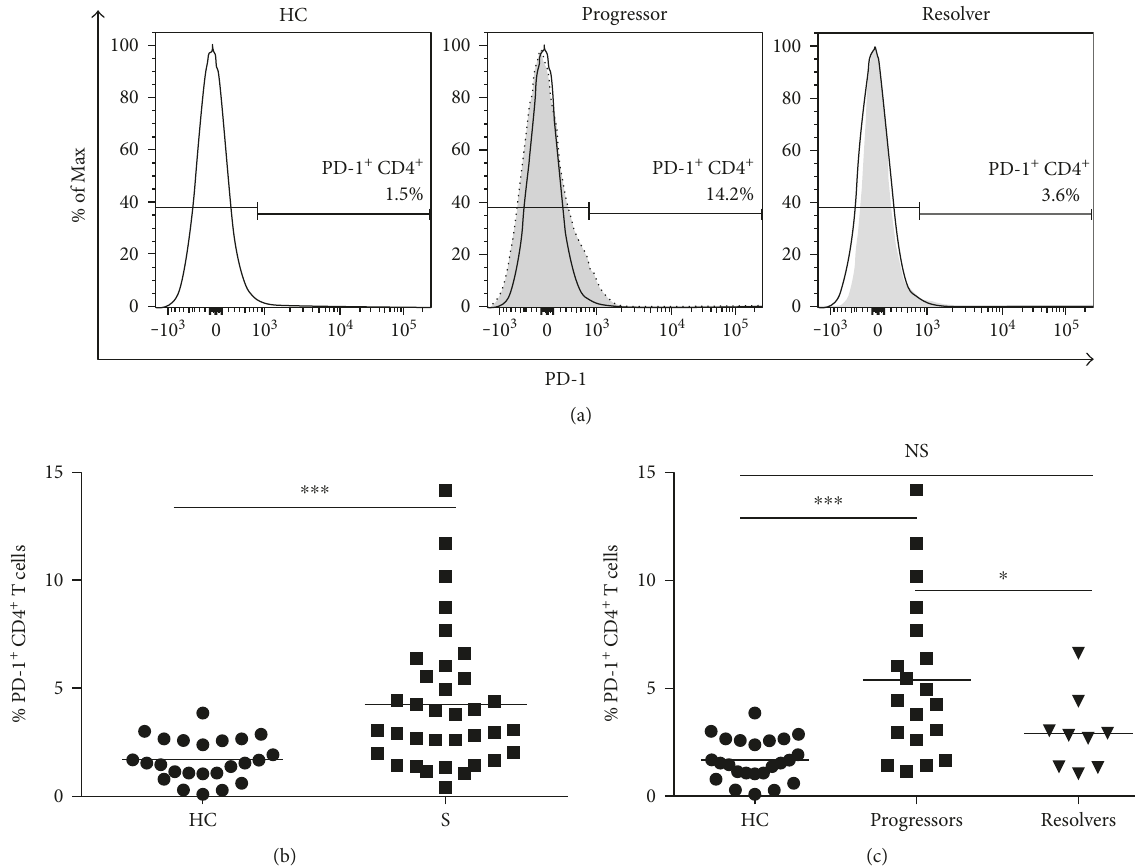
Figure 4: PD-1 upregulation in sarcoidosis CD4 + T cells. PBMC isolated from the whole blood of healthy control, and sarcoidosis subjects were stained using anti-CD3, anti-CD4, anti-CCR7, anti-CD45RO, and anti-PD-1 antibodies. (a) Representative fl ow cytometry histograms to illustrate PD-1 gating in the population of CD4 + T cells from healthy control and sarcoidosis progressor and resolver subjects. For comparison, the healthy control histogram (black trace) was overlayed with the sarcoidosis progressor and resolver histogorams. (b) Plot of the percentages of sarcoidosis PD-1 + CD4 + T cells relative to healthy controls. Statistical analysis was performed using the Mann – Whitney U test. (c) Plot of PD-1 + CD4 + T cells present during sarcoidosis disease progression and resolution relative to healthy controls. Statistical analysis was performed using one-way ANOVA with Tukey ’ s HSD. Horizontal lines indicate mean percentages of PD-1 + CD4 + T cells. ∗ p < 0 05 and ∗∗∗ p < 0 001 . NS: not signi fi